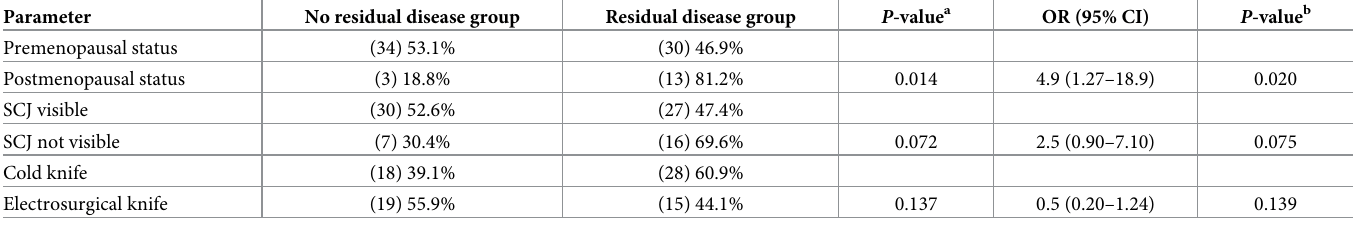
Table 3. Analysis of menopausal status, squamocolumnar junction (SCJ) status and surgical technique as possible risk factors for the presence of residual disease in the hysterectomy specimens of women after conization for CIN 2/3 with endocervical cone margin involvement.